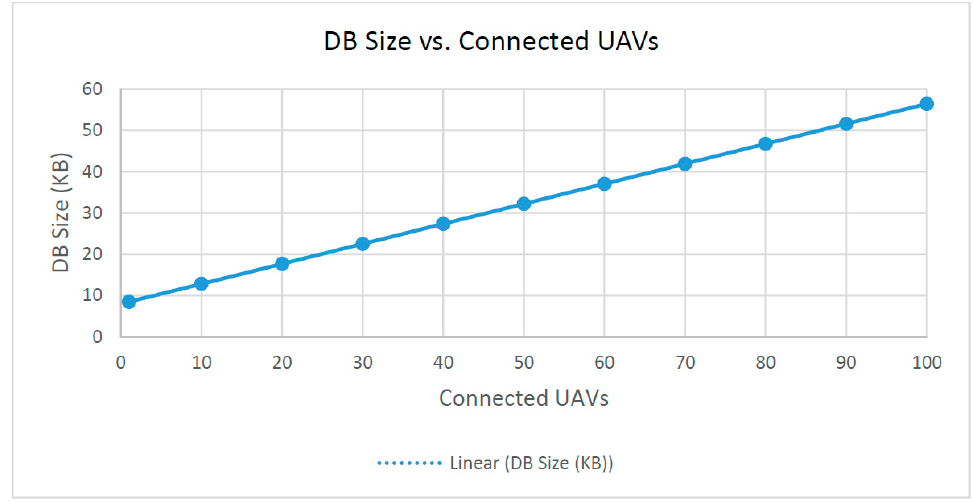
Figure 12. Required DB size on server vs. connected UAVs.